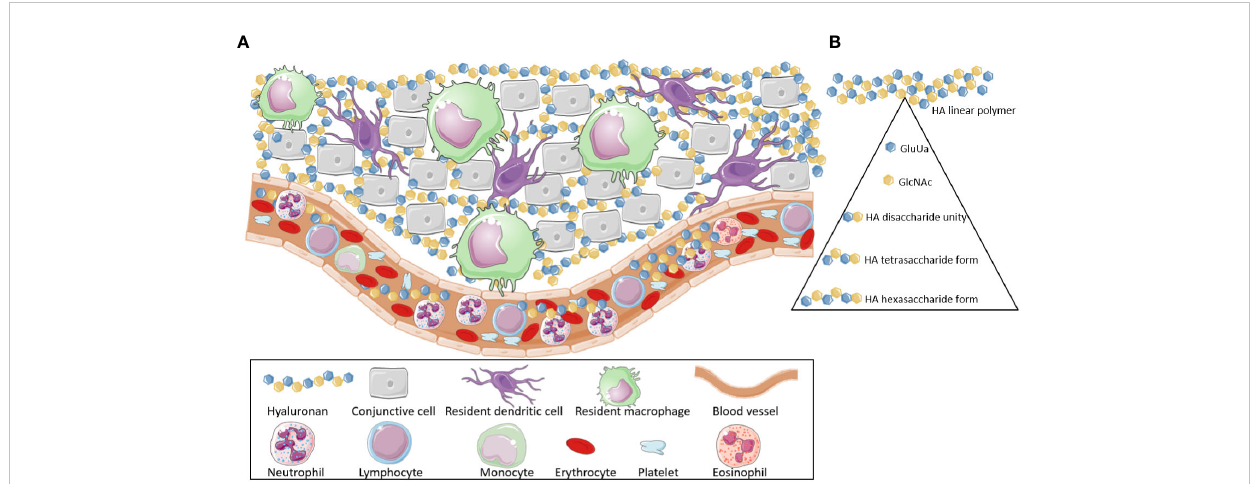
FIGURE 1 Hyaluronan location and composition. (A) Hyaluronan molecules are broadly found through the body, mainly in the extracellular matrix of different tissues. Additionally, they can also be detected in the bloodstream. (B) Hyaluronan is a high molecular weight polymer (>800 kDa). It is composed by subunits of D-glucuronic acid (GluUA) and N-acetyl-D-glucosamine (GlcNAc) that are attached, via glucuronic beta 1-3 linkage, thus forming disaccharide unities, which are the structural base of the Hyaluronan polymers. These disaccharide unities, when linked through hexosaminic beta 1- 4 bonds (between GlcUA and GlcNAc), generate tetrasaccharides. The association of various tetrasaccharide units leads to the formation of the high molecular weight hyaluronan (HMW-HA). Low Molecular Weight Hyaluronan fragments (LMW-HA) are released, after cleavage of HMW-HA, by hyaluronidases and -hexosaminidases enzymes or by Reactive Oxygen Species. These fragments are Damage Associated Molecular Patterns (DAMPs), which act as pro-in fl ammatory and immunopathological agents. This Figure was partly generated using Servier Medical Art, provided